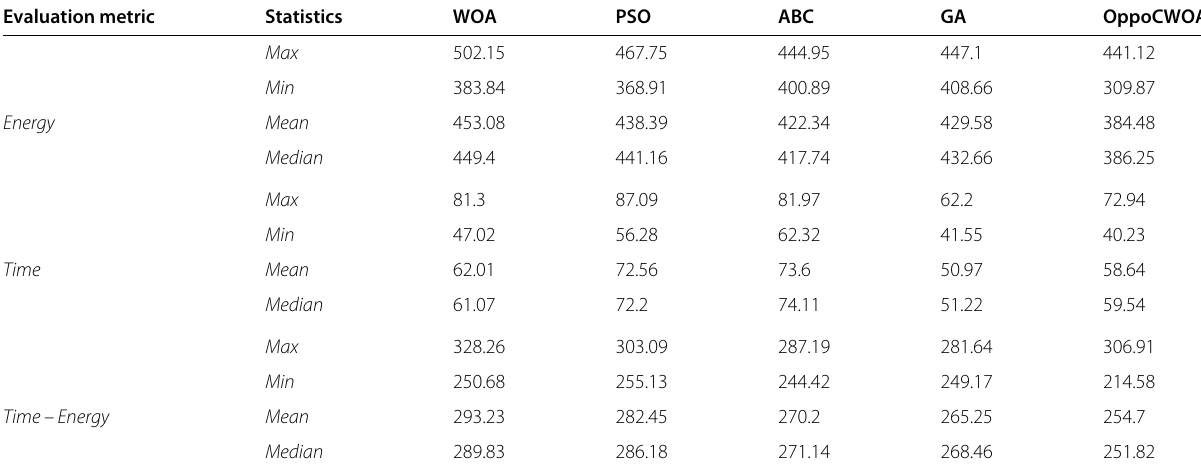
Table 11 Results of 5 task scheduling algorithms on all evaluation metrics Evaluation